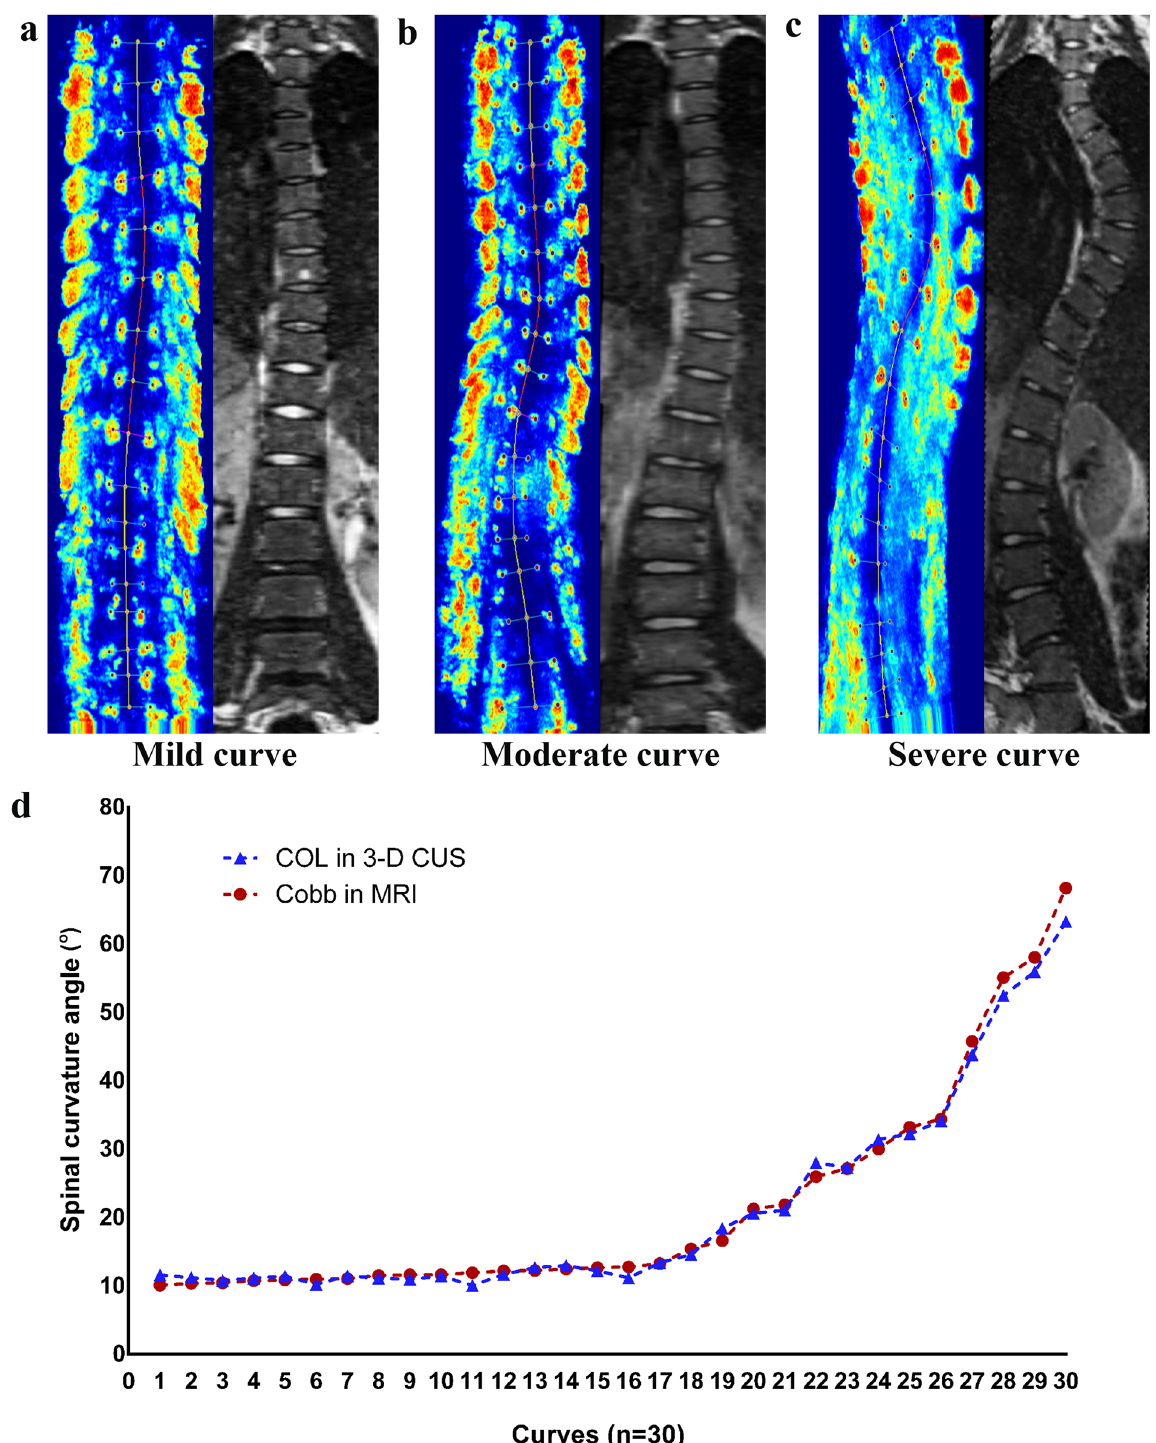
Fig 4. Comparison of ultrasound versus MRI images for AIS patients with. (a) Mild curve; (b) Moderate curve; (c) Severe curve; (d) A scatter plot of the COL method in ultrasound versus the Cobb method in MRI for the entire curve cohort.